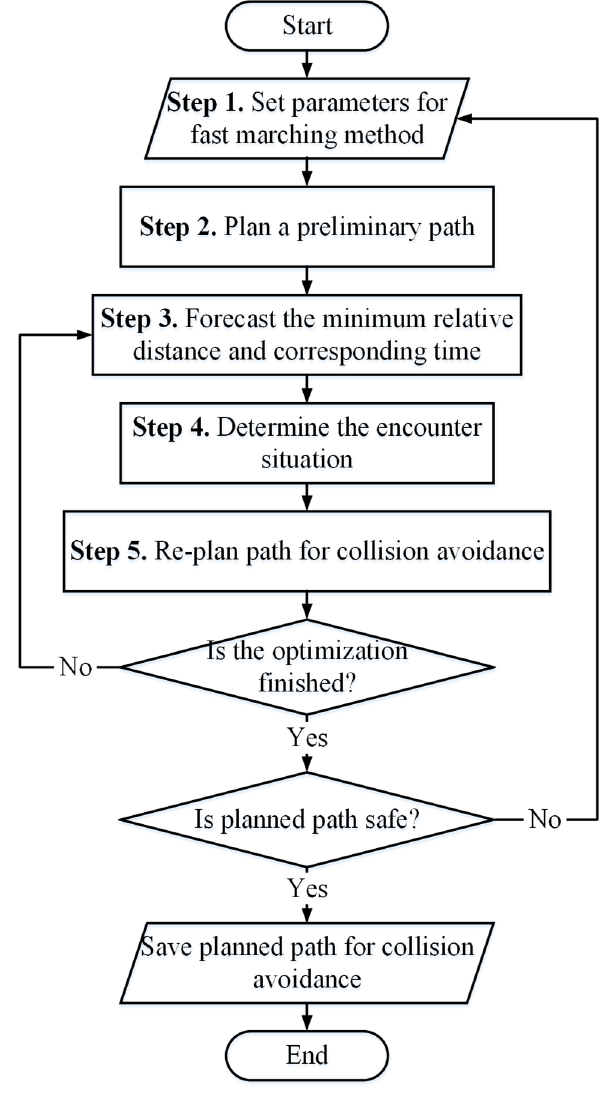
Figure 1. The flow chart of the proposed path planning approach.